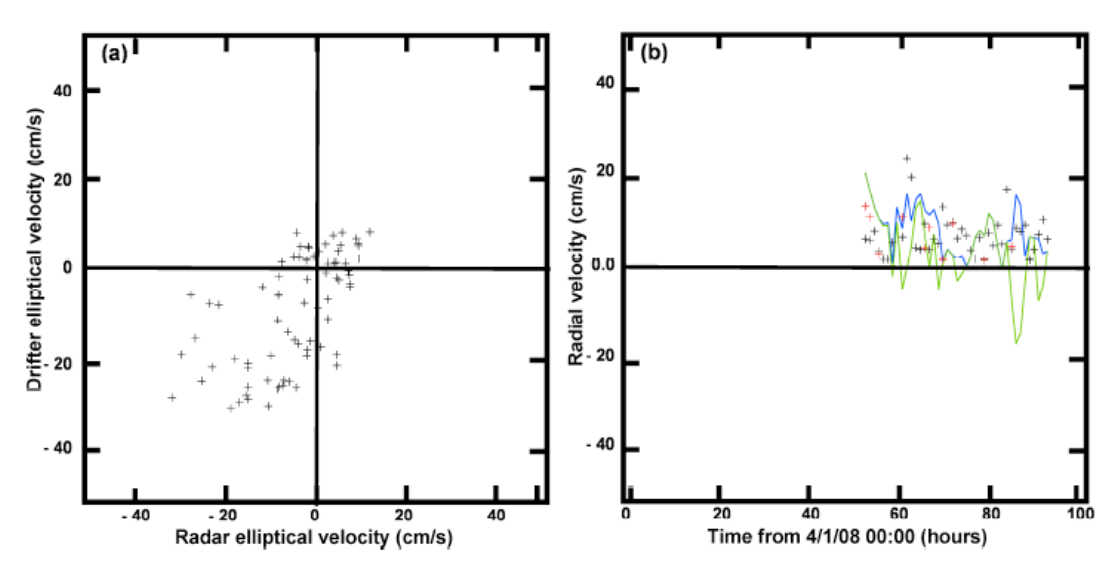
Figure 14. (a) Scatter plot of elliptical velocity data points: Drifter vs radar; (b) Comparison statistics averaged over the map, plotted vs. time: Blue—standard deviation between radar and drifter elliptical velocities. Green—bias. Red—spatial standard deviation in COMM ellipticals. Black—temporal standard deviation in COMM ellipticals.